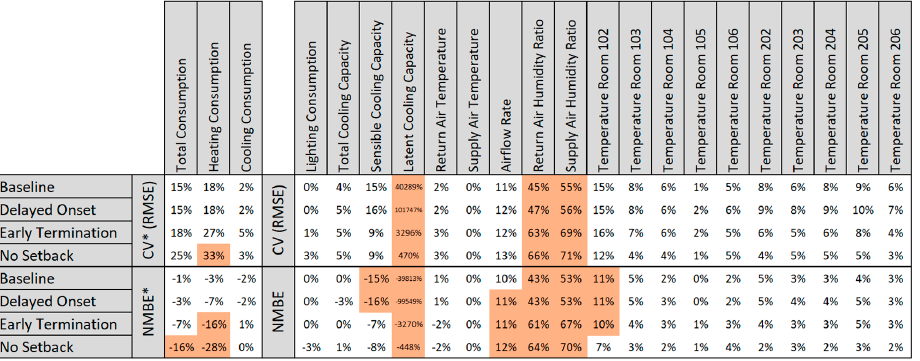
Table 5. CV (RMSE) and NMBE Calculations for Detailed Model Outputs: Lighting Setback Error.